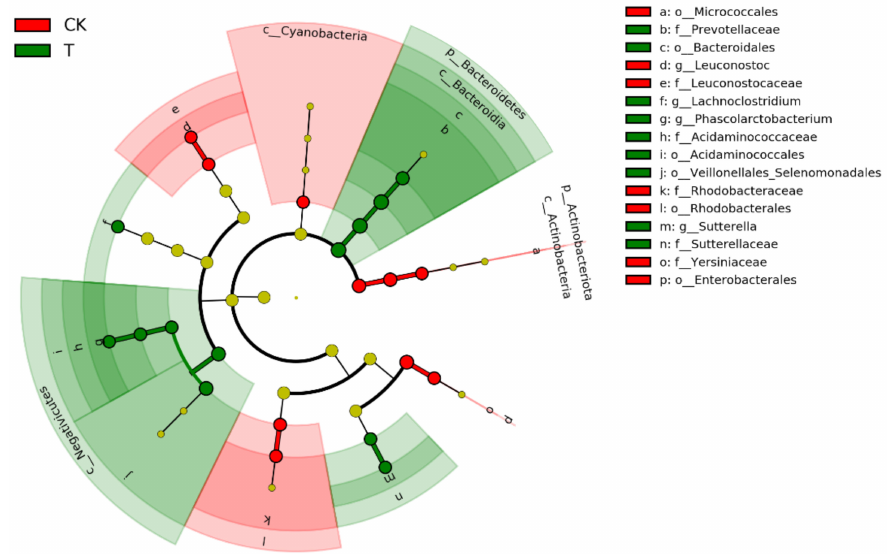
Figure 5. Cladogram of bacterial biomarkers of the gut microbiota samples of Grapholita molesta , from the phylum (innermost ring) to genus (outermost ring) level, with an LDA score > 3.5. CK: control; T: treatment with ciprofloxacin. Each small circle represents a taxon, and a large diameter of the circle indicates a high relative abundance of that taxon. Different lowercase letters represent different bacterial taxa. Taxa with no insignificant differences are shown in yellow, taxa with higher relative abundance in treatment groups than control groups are shown in green, and taxa with higher relative abundance in control groups than treatment groups are shown in red.